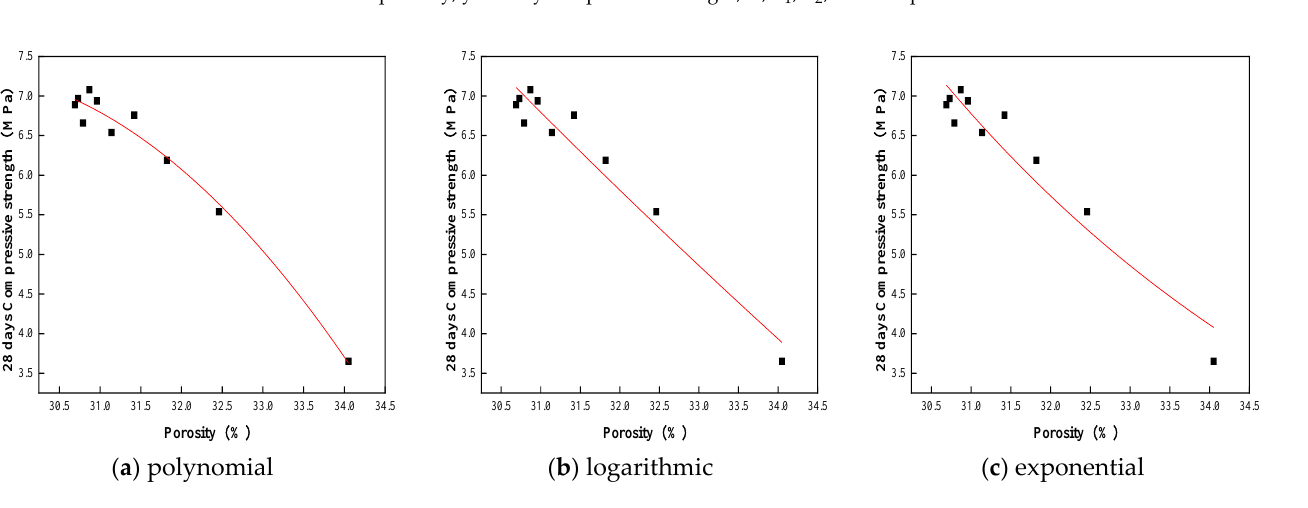
Exponential function